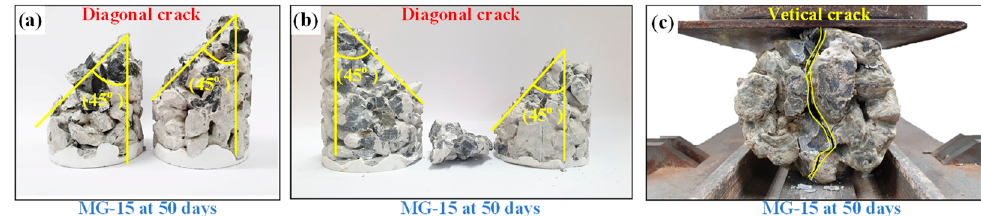
Figure 13. Typical failure modes of CFG specimens in the ( a ) unconfined compression, ( b ) triaxial compression, and ( c ) splitting tensile tests. compression, and ( c ) splitting tensile